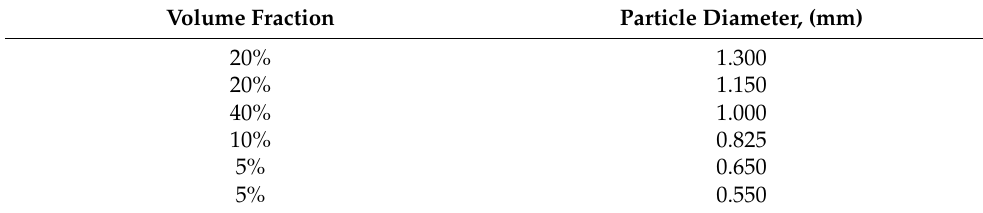
Table 1. Particle size distribution of powder particles.